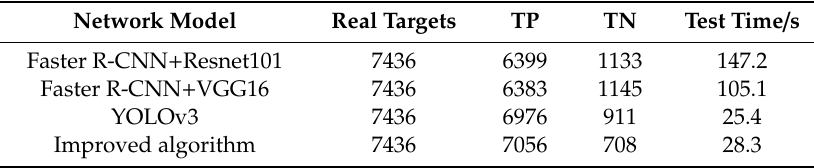
Table 1. Detection results of four models on the MyPlane dataset.